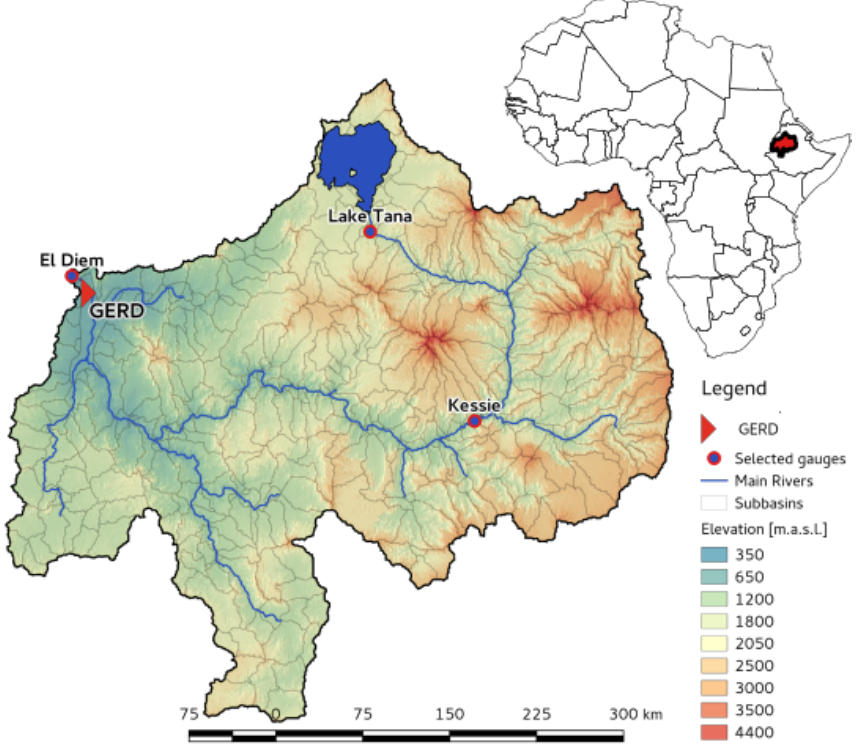
Figure 1. Map of the Upper Blue Nile catchment (UBN) in